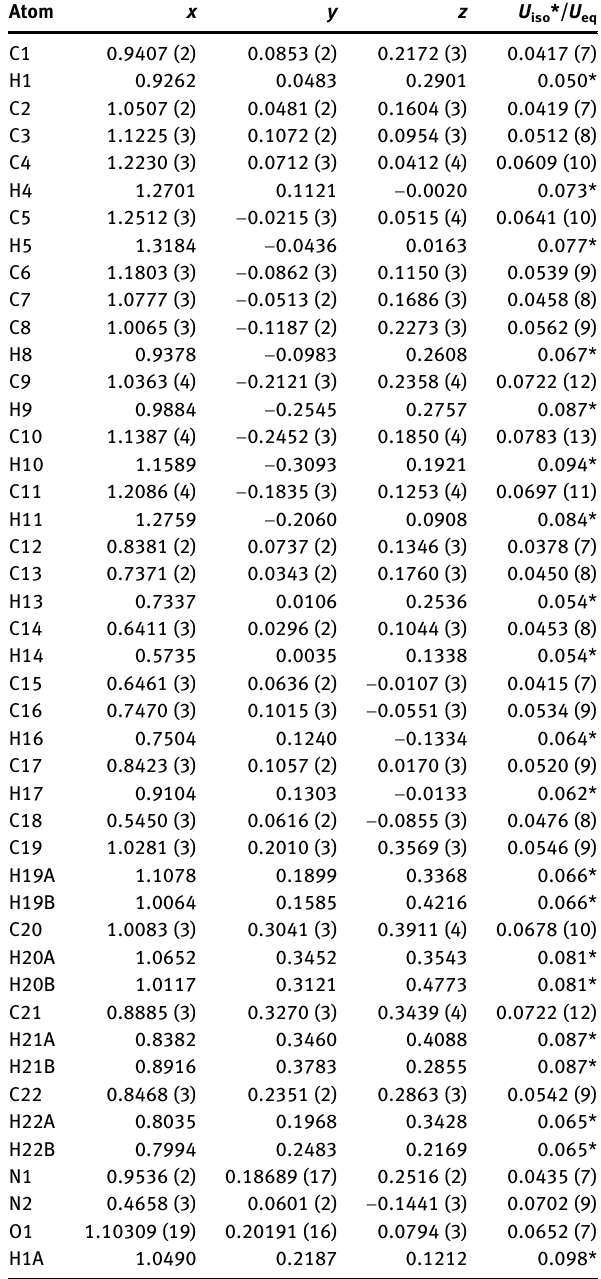
Table  : Fractional atomic coordinates and isotropic or equivalent isotropic displacement parameters (Å 